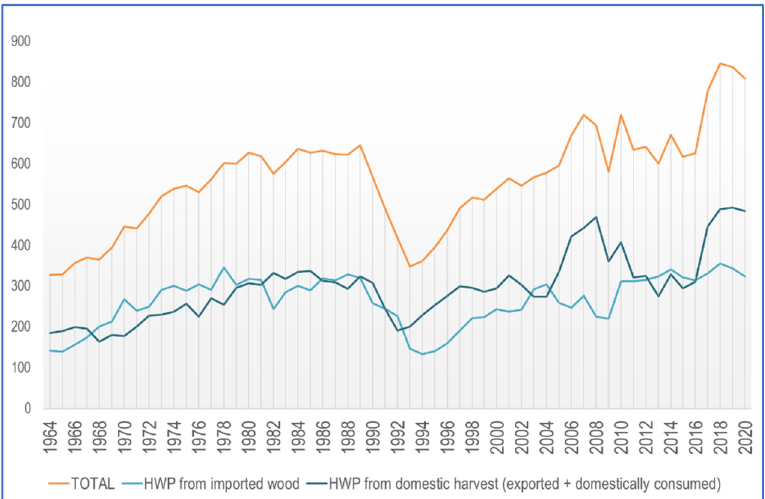
Figure 6. Inflow to the HWP pool from imported wood and from domestic harvest in time period of 1964–2020 (kt C/year).